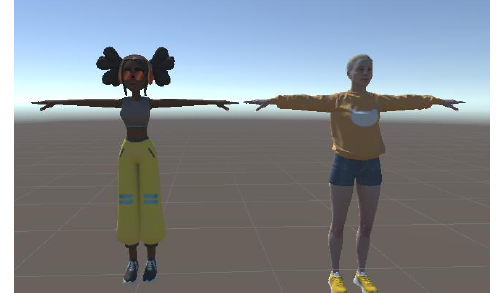
Figure 17. Couples in